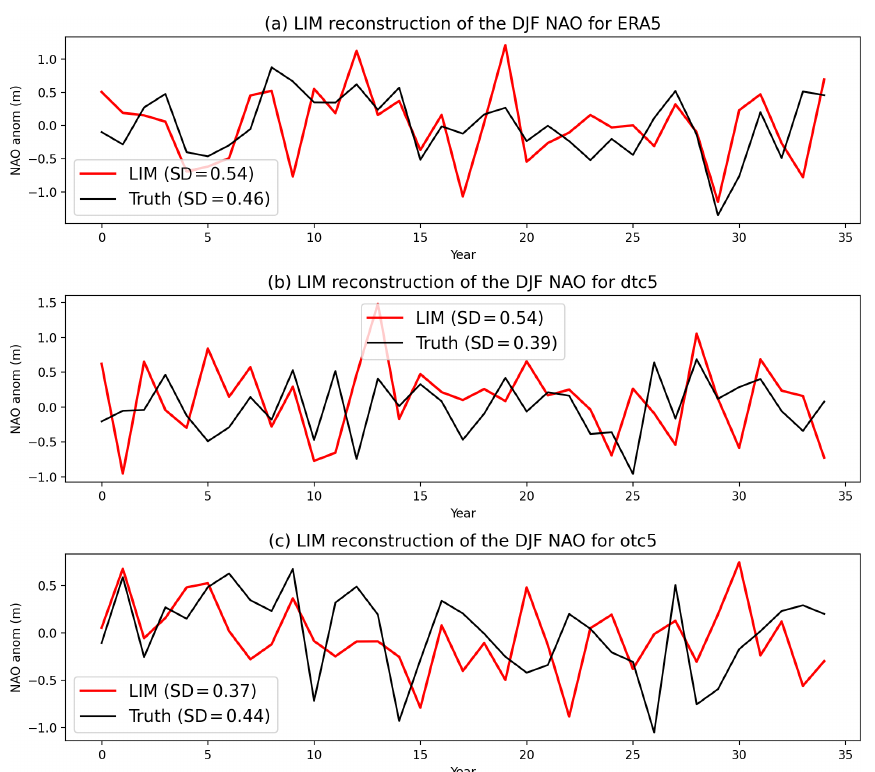
Figure B7. Randomly generated reconstructions of the DJF NAO time series using the LIM initialized each 1 November for the years 1980 to 2015. For (a) ERA5, (b) the fifth ensemble member of CTRL, and (c) the fifth member of OCE. In each plot, the LIM reconstruction is in red and the true time series in black. The sample standard deviations of each time series have been noted in the legends. Reconstructions of other ensemble members of CTRL and OCE are qualitatively similar.